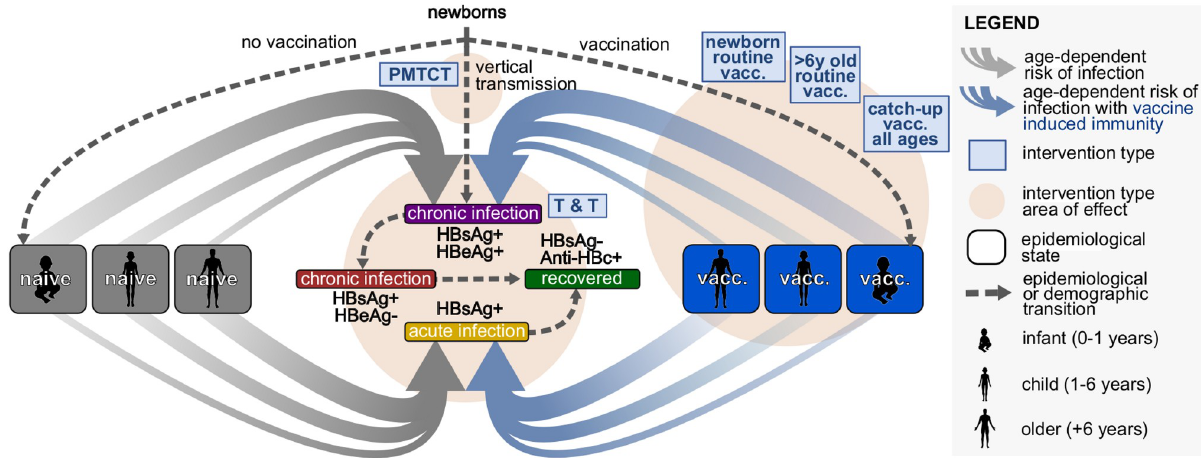
Fig 2. Summary diagram of the dynamic model used to fit the seroepidemiology of HBV in Uganda. The na ï ve (grey rounded boxes) and vaccinated (blue rounded boxes) subpopulations are divided into 3 relevant age groups: infant (0–1 years), child (1–6 years), and older (+6 years). This allows us to consider a relationship between the likelihood of developing chronic or acute infection with age (represented by the thickness of the grey and blue arrows). Individuals can acquire infection in any age group. When acutely infected (yellow rounded box), individuals may clear infection and recover (green rounded box). When chronically infected, individuals can be HBeAg positive (purple rounded box) and transit to become HBeAg negative (red rounded box), after which they may recover (green rounded box). Interventions (light blue squared boxes) target different epidemiological states and transitions (orange circles). Vertical transmission can occur from infected mothers to newborns. Protection mediated by infant vaccination is age dependent due to waning and is assumed to lower susceptibility to infection. Parameters are listed in S1 Table. Artwork supported by figures created with BioRender.com. anti-HBc, antibody to hepatitis B core antigen; HBeAg, hepatitis B e-antigen; HBsAg, hepatitis B surface antigen; HBV, hepatitis B virus; PMTCT, prevention of mother to child transmission; T&T, Test and Treat.